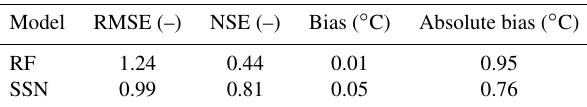
Figure B1. Histogram of the median date for the hottest 30d peri- ods across all sites that had annual data. The 30d rolling windows of mean daily stream temperature were calculated across the entire time series and for each site, and the 30d windows with the max- imum values were selected here. The median date here refers to day 15 in the 30d period. Table B1. Comparison of model performance metrics for the region tested in Fig. B5.